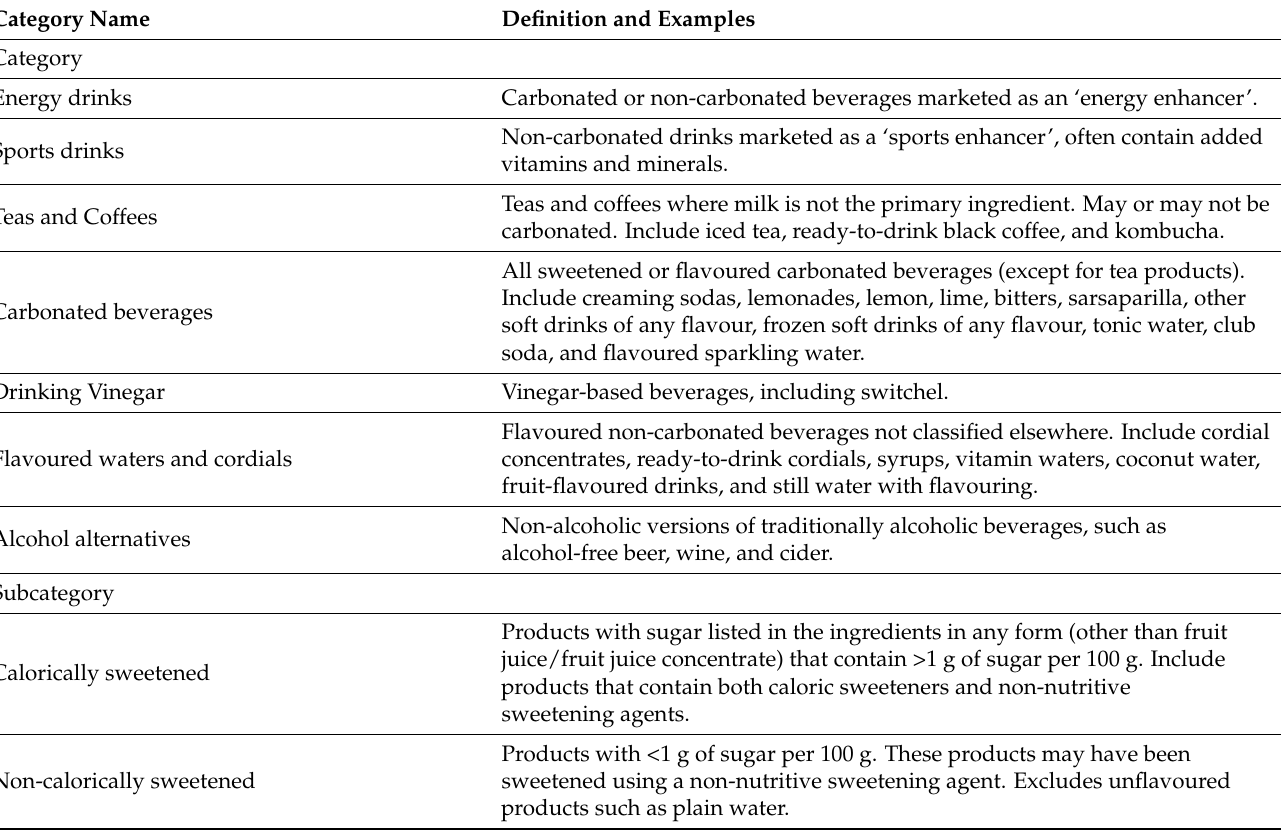
Table 1. Definitions and product examples for categories and subcategories of included